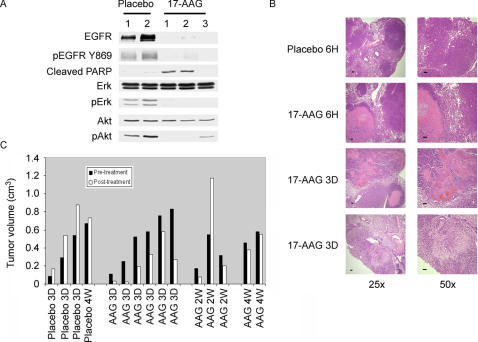
Effect of 17-AAG on lung tumors from C/L858R+T790M animals.A. Immunoblotting analyses of lung lysates derived from bitransgenic animals (line 51) treated with placebo or 17-AAG and sacrificed 6 hours later. Lane numbers correspond with the animal study numbers in Table S3. Lysates were probed with the indicated antibodies; p-phospho. B. Histology of lung tumors from bitransgenic mice treated with either placebo or 17-AAG for indicated times; H–hours; D–days. Lungs from placebo treated mice had viable tumor (upper panels), while lungs from drug-treated animals displayed areas of tumor necrosis surrounded by rims of viable cells (two middle panels), and degenerating tumors with inflammatory response (lower panels). Bars, 100 microns. C. Tumor volumes were quantitated in the MR images obtained from the individual mice pre- and post-treatment with placebo or 17-AAG. See Table S3 and methods for details. D–days; W–weeks.